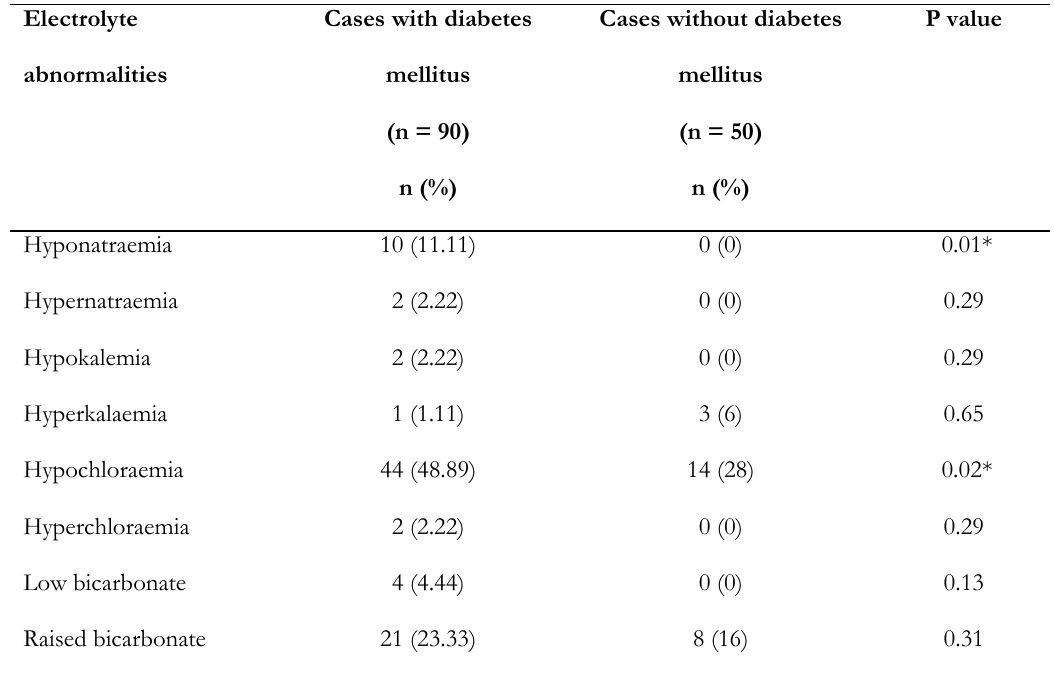
Table 4 Electrolyte abnormalities in the study population